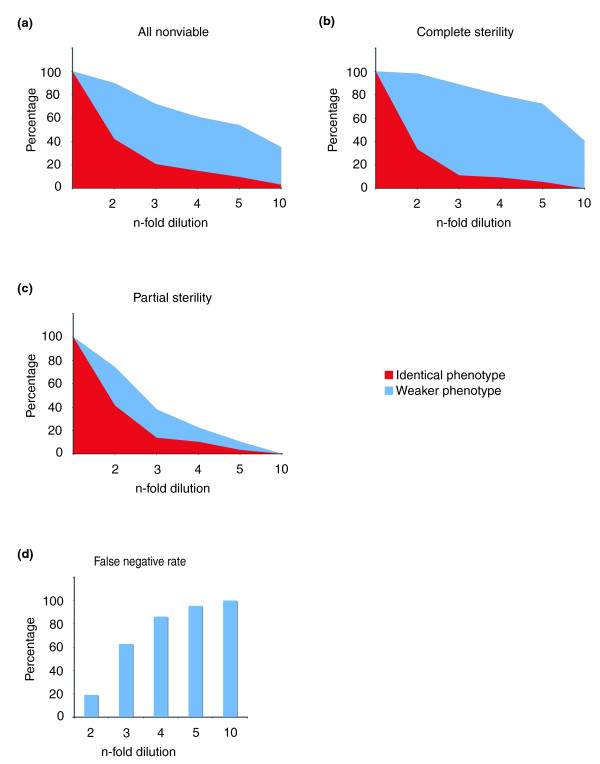
Effect of dilution on strength of RNA interference (RNAi) phenotype. The RNAi phenotype of each nonviable gene on chromosome III [2] was assessed following dilution with increasing amounts of bacteria expressing a nontargeting double-stranded (ds)RNA. The percentage of genes with phenotypes that are either identical to that observed when targeted alone (red) or weaker than when targeted alone (blue) is shown for each dilution. This was examined for three phenotypes: (a) all nonviable phenotypes, (b) complete sterility (no progeny), and (c) partial sterility (some progeny). (d) False negative rate (in percentage) of combinatorial RNAi at a given dilution. Data shown are representative of two independent experiments performed in the RNAi-hypersensitive rrf-3 background [19].